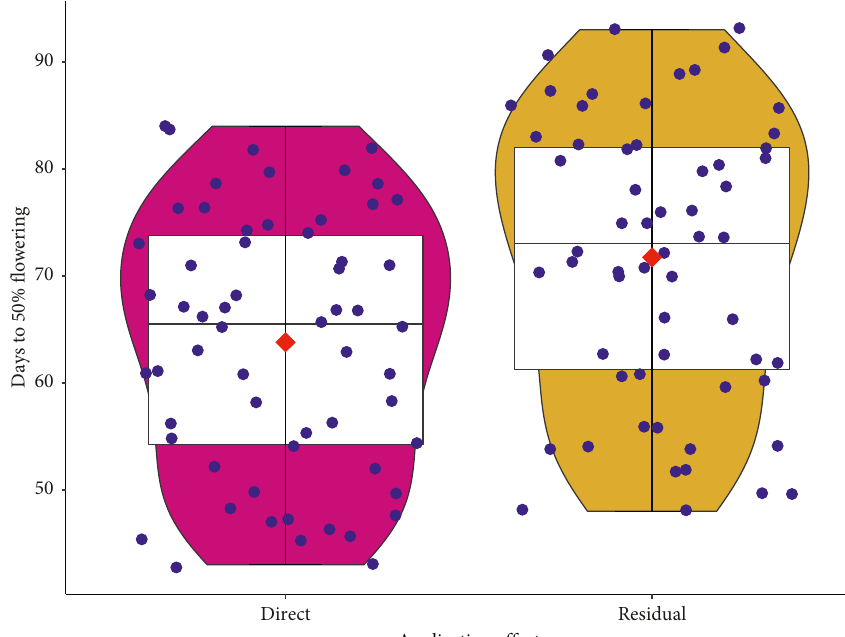
Figure 7: Response of days to 50% flowering to organic amendment application effects, combined graphs of boxplot, geom violin, and geom point; red diamond is the mean values